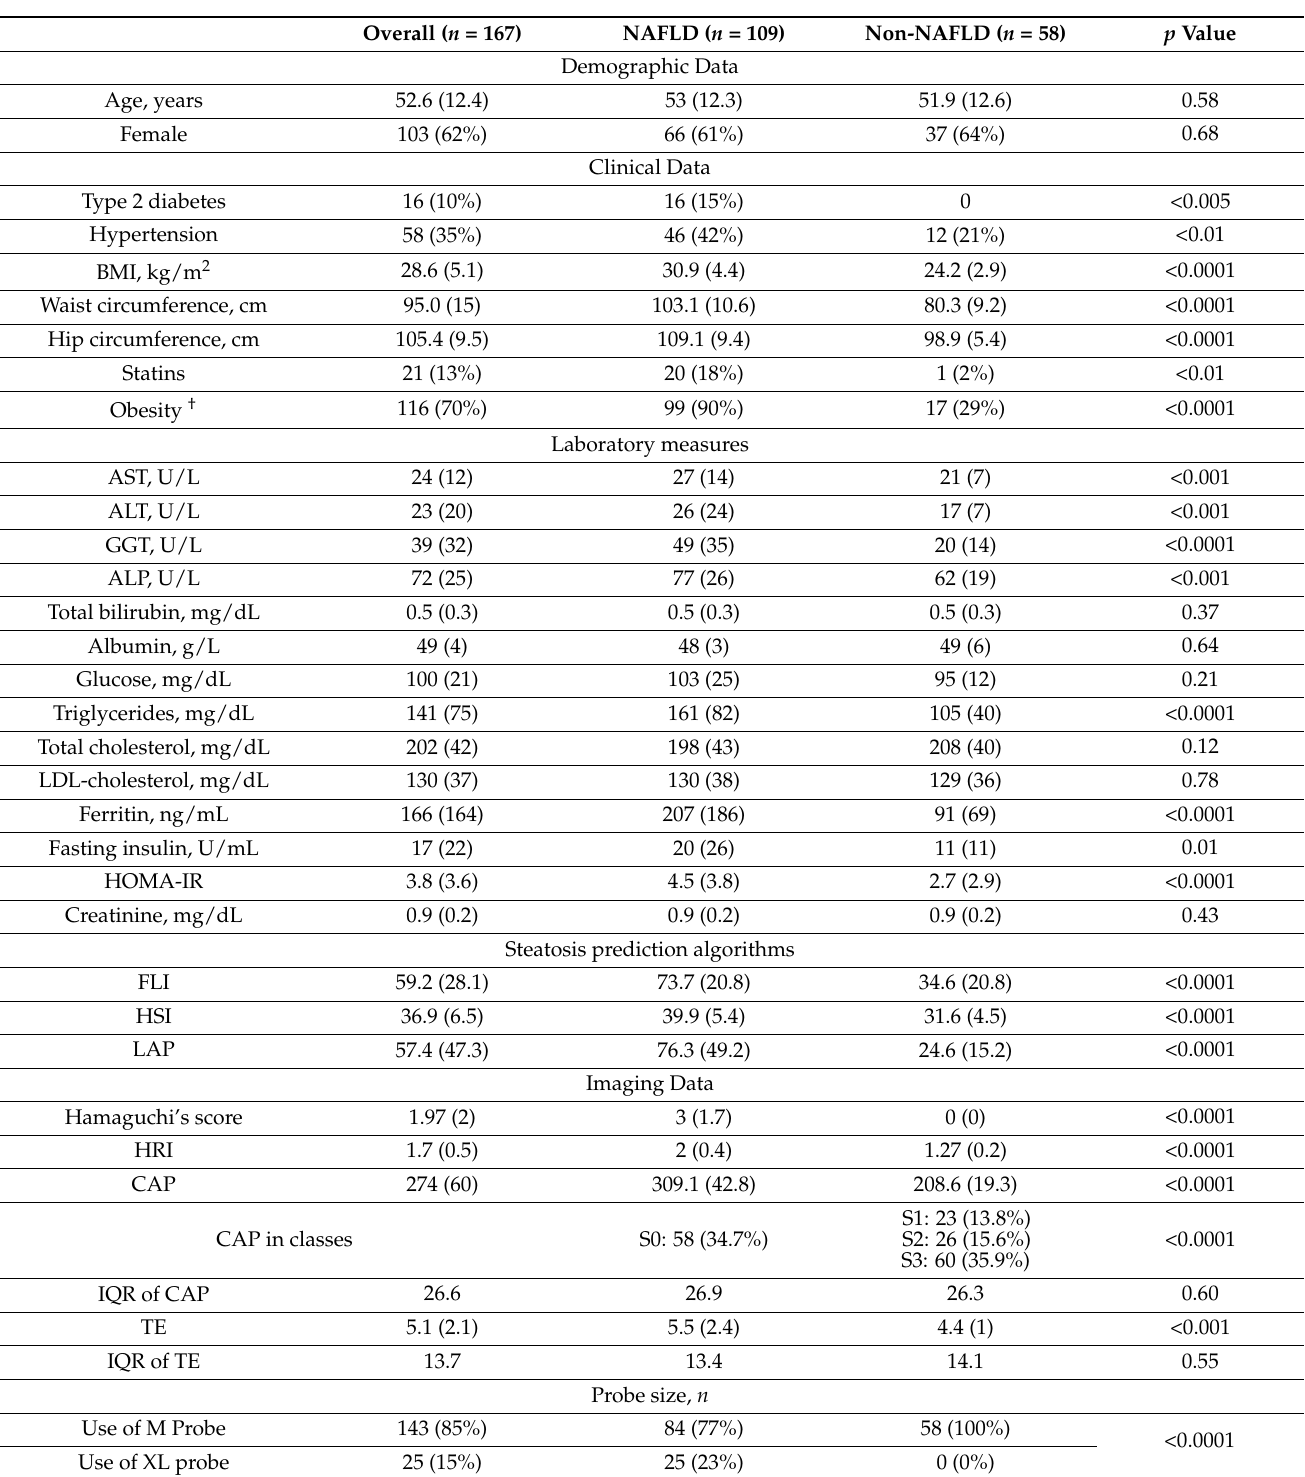
Table 1. Baseline characteristics of participants stratified by the presence of nonalcoholic fatty liver disease NAFLD (CAP ≥ 234